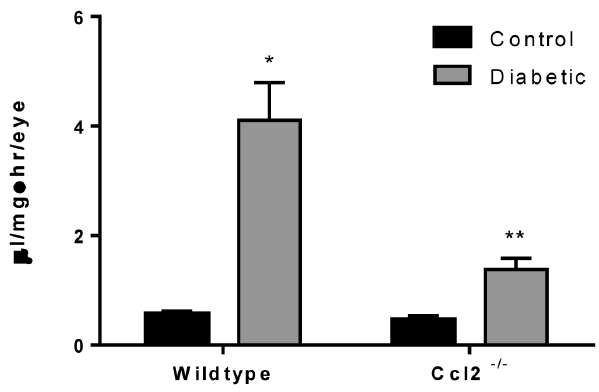
Figure 7. Diabetic Ccl2 2 / 2 mice show a reduction in retinal vascular permeability. The modified Evans Blue dye technique was performed in wildtype and Ccl2 2 / 2 mice with 6 weeks of diabetes. Wildtype mice demonstrate a nearly 4-fold increase in retinal vascular permeability compared to non-diabetic. The degree of permeability is significantly reduced in Ccl2 2 / 2 mice. *Significantly greater than wildtype non-diabetic (p=0.001). **Significantly less than wildtype diabetic animals and significantly greater than non-diabetic controls